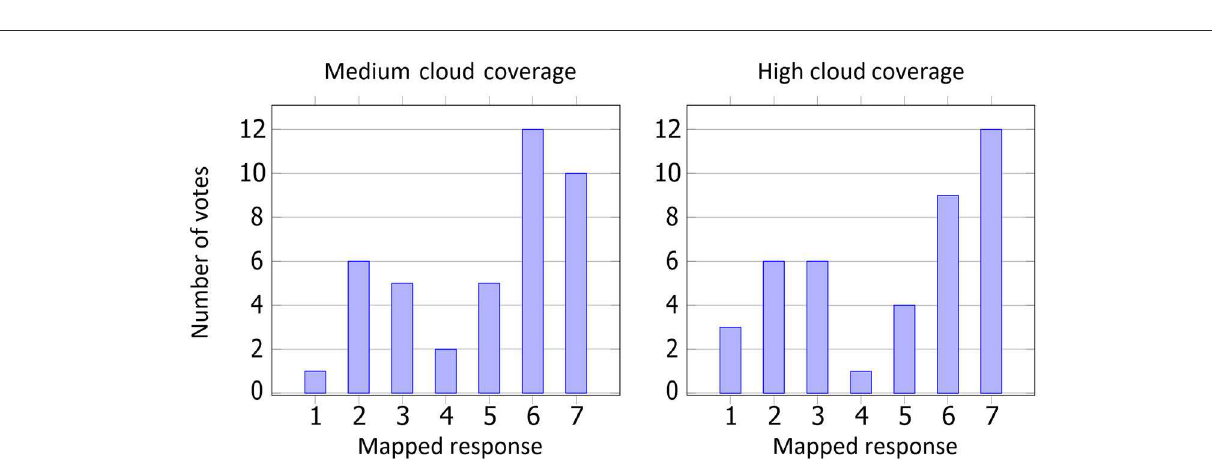
(ignoring the neutral scores) for the medium and high cloud coverages,